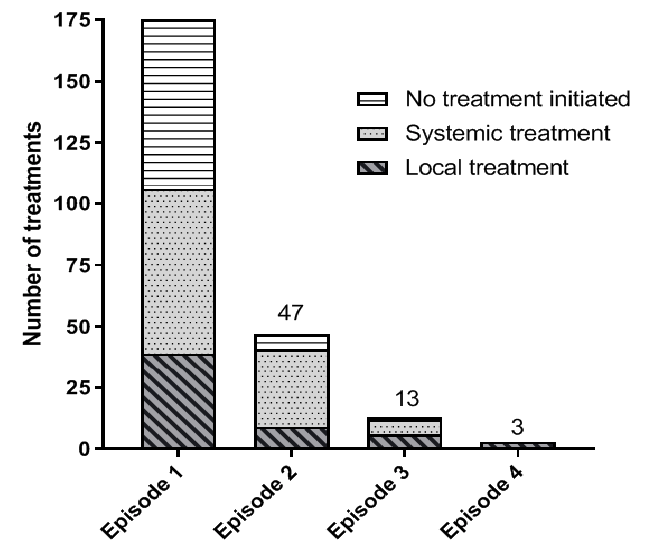
Figure 4. Treatment strategies per treatment episode. Some patients received more than one line of treatment after failure of first-line treatment. (treatment episode 1: treatment strategy performed when diagnosed with metastatic uveal melanoma, treatment episode 2: second treatment strategy after failure of first-line treatment etc.).